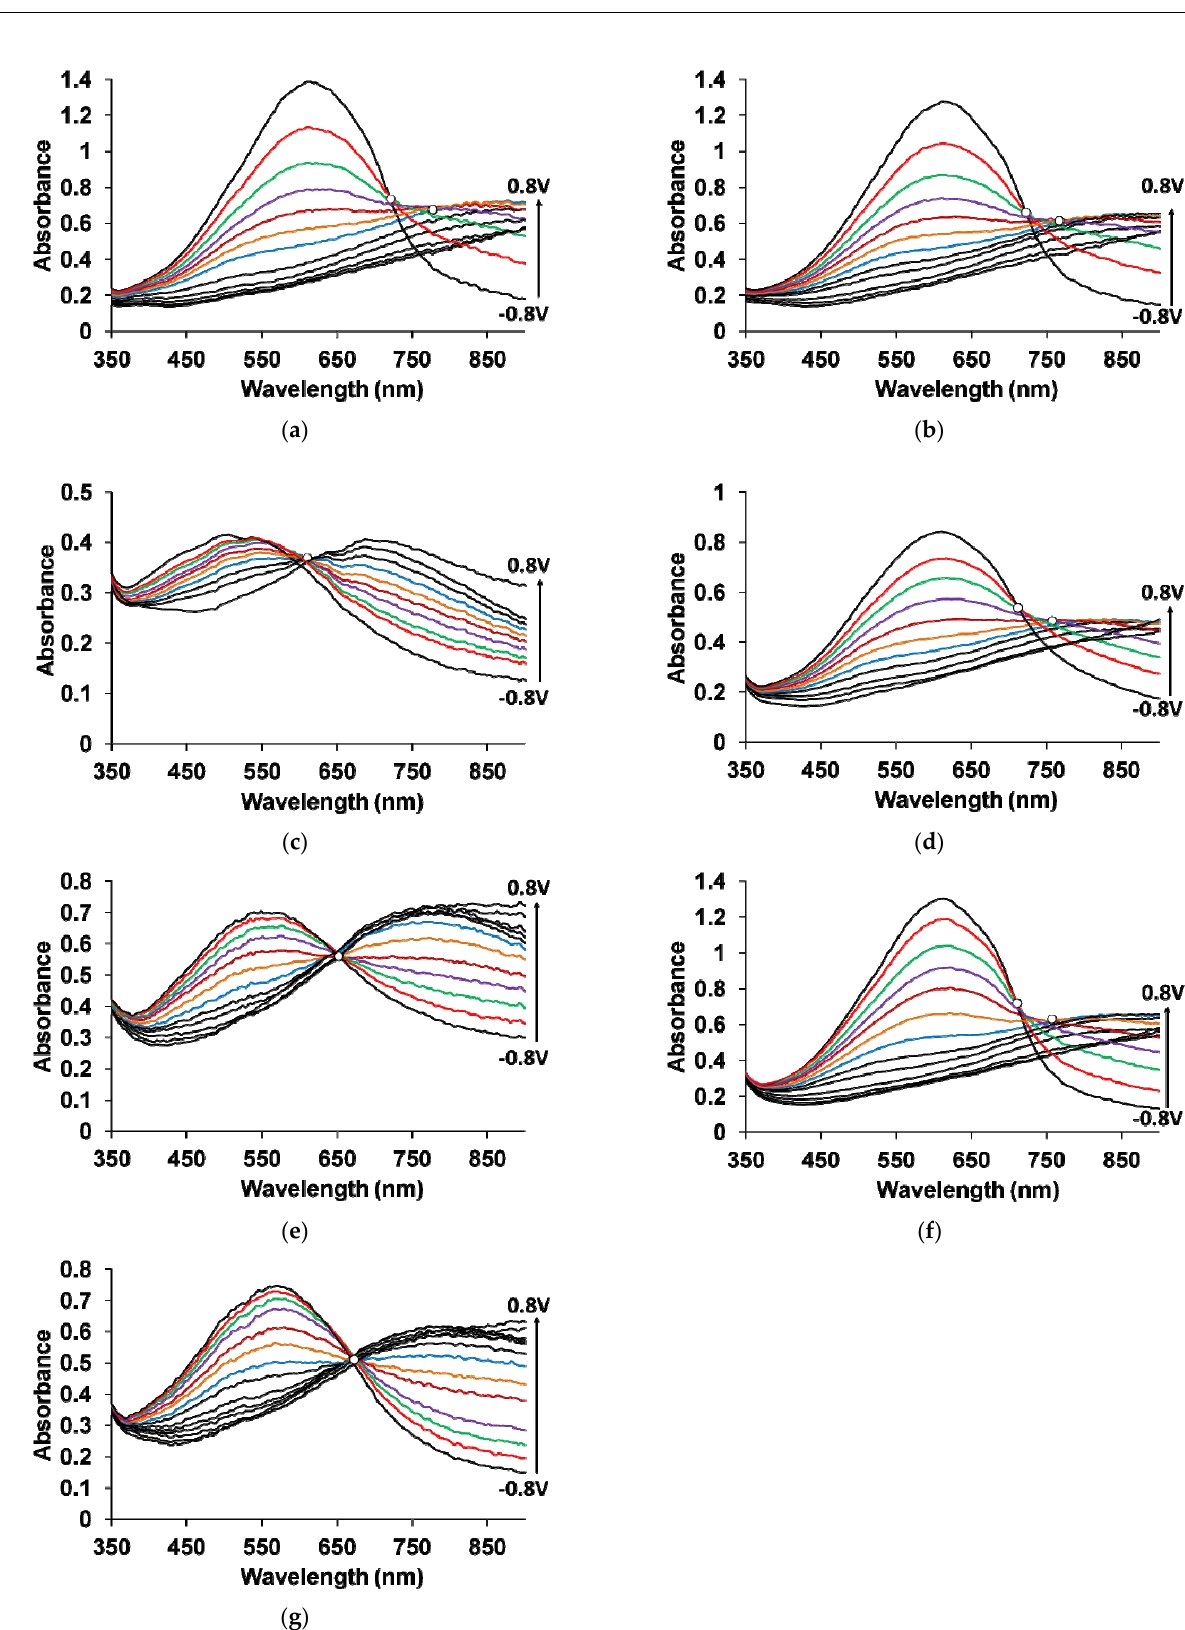
Figure 6. Optical absorption spectra of PEDOT films prepared in PAMPSA ( a ), PAMPSNa ( b ), t-PASA ( c ), t-PASNa ( d ), PAMPSA/t-PASA 1:1 ( e ), PAMPSNa/t-PASNa 1:1 ( f ) and PAMPSA/t-PASA 2:1 ( g ) measured at different potentials in 0.5 M aqueous solution of NaClO 4 . Table 2. The positions of the maxima of the absorption bands of the reduced and polaronic forms of PEDOT and the isosbestic points i.p.1 (neutral-to-polaron) and i.p.2 (polaron-to-bipolaron). PEs